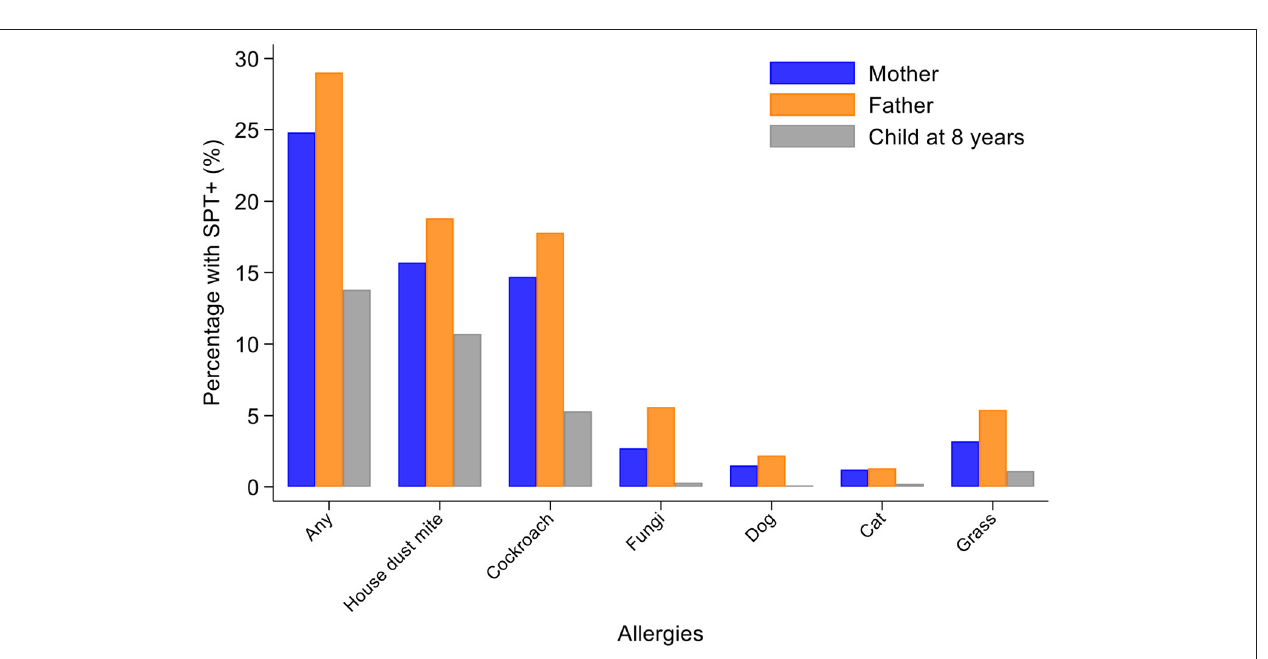
(equivalent to meeting a household’s basic needs) (OR